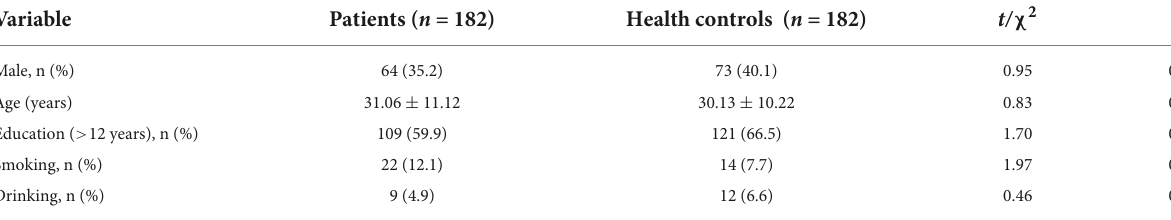
TABLE 1 Social demographic of BPD patients and health